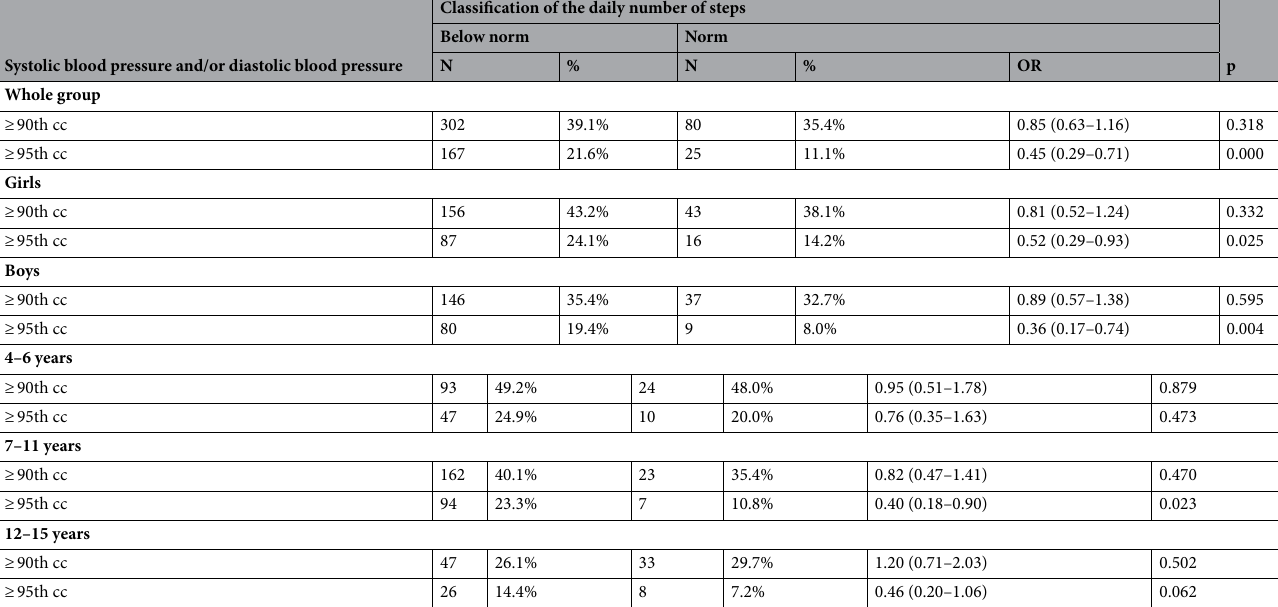
Table 4. Incidence of hypertension depending on the number of steps in girls and boys. N number of participants, p probability level, OR odds ratio with 95% confidence interval, 90th, 95th percentile, “ norm ” at least 11,500 steps a day; “ below norm ” a number of steps a day below